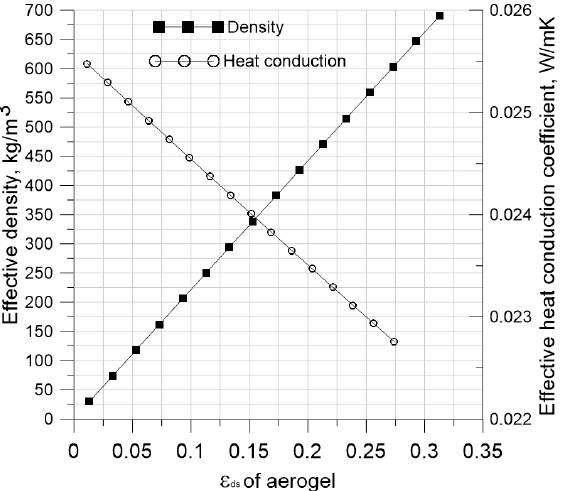
Figure 11. Influence of the volume fraction of aerogel ε ds on the effective density and coefficient of thermal conductivity in the center of the insulating layer (batting) of clothing.